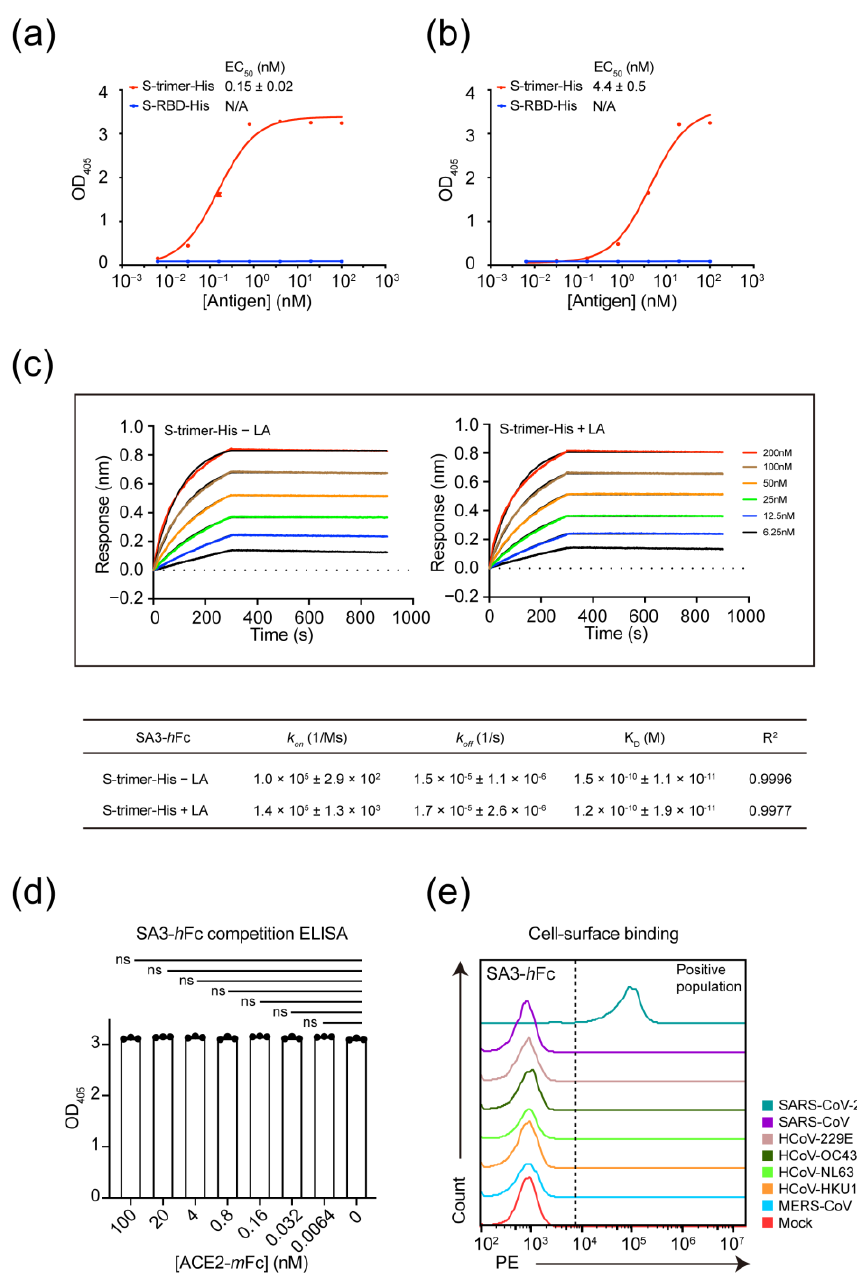
Figure 2. Characterization of interactions between SA3 and S proteins of coronaviruses. ( a ) Com- parison of interactions between SA3- h Fc and biotinylated S-RBD-His (blue traces) and S-trimer-His (red traces) by ELISA. ( b ) Comparison of interactions between SA3-IgG1 and biotinylated S-RBD-His (blue traces) and S-trimer-His (red traces) by ELISA. ( c ) Kinetic characterization of SA3- h Fc binding to S-trimer-His by BLI in the absence (left panel) and presence (right panel) of 50 µ M LA (Linoleic Acid). Sensorgram curves at various concentrations (colored traces) were fitted to the superimposed black lines by a 1:1 binding model with a globally linked R max using the ForteBio. Kinetic parameters are summarized in the table. ( d ) Competitive binding of SA3- h Fc to S-trimer-His in the presence of various concentrations of ACE2- m Fc by ELISA. ( e ) FACS analyses of the association of SA3- h Fc with HEK293T cells expressing spikes of various coronaviruses (colored traces indicated in the figure) on the membrane. All the ELISA experiments were carried out in triplicate ( n = 3) and monitored by the absorbance change at wavelength 405 nm (OD 405 ). Dose-response curves were fitted by the Hill equation to obtain EC 50 values. Statistical analysis was carried out by one-way ANOVA in GraphPad